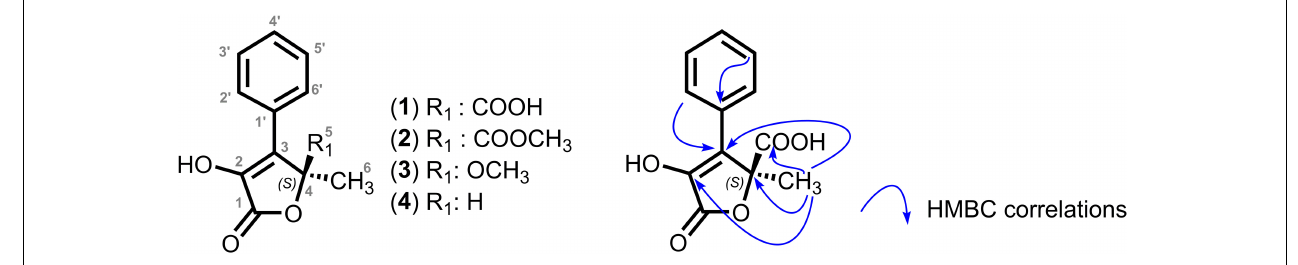
Frontiers in Marine Science |